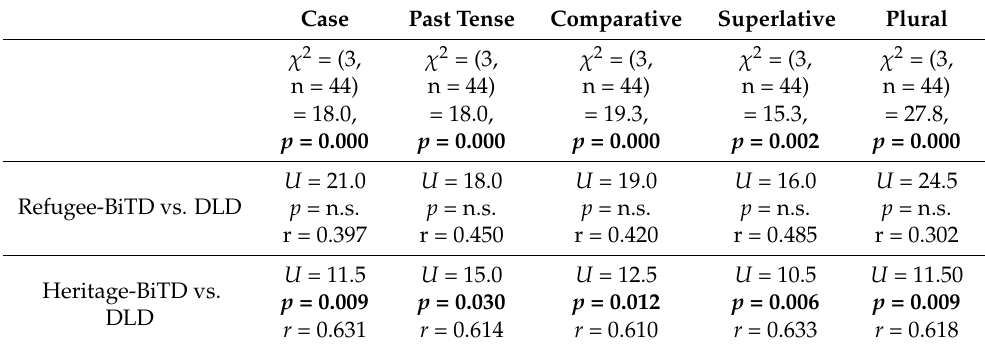
Table 4. Group effects (Kruskal–Wallis tests) and pairwise comparisons (Mann–Whitney U tests) between groups and grammatical categories of the subtest of grammar. Significant values are given in